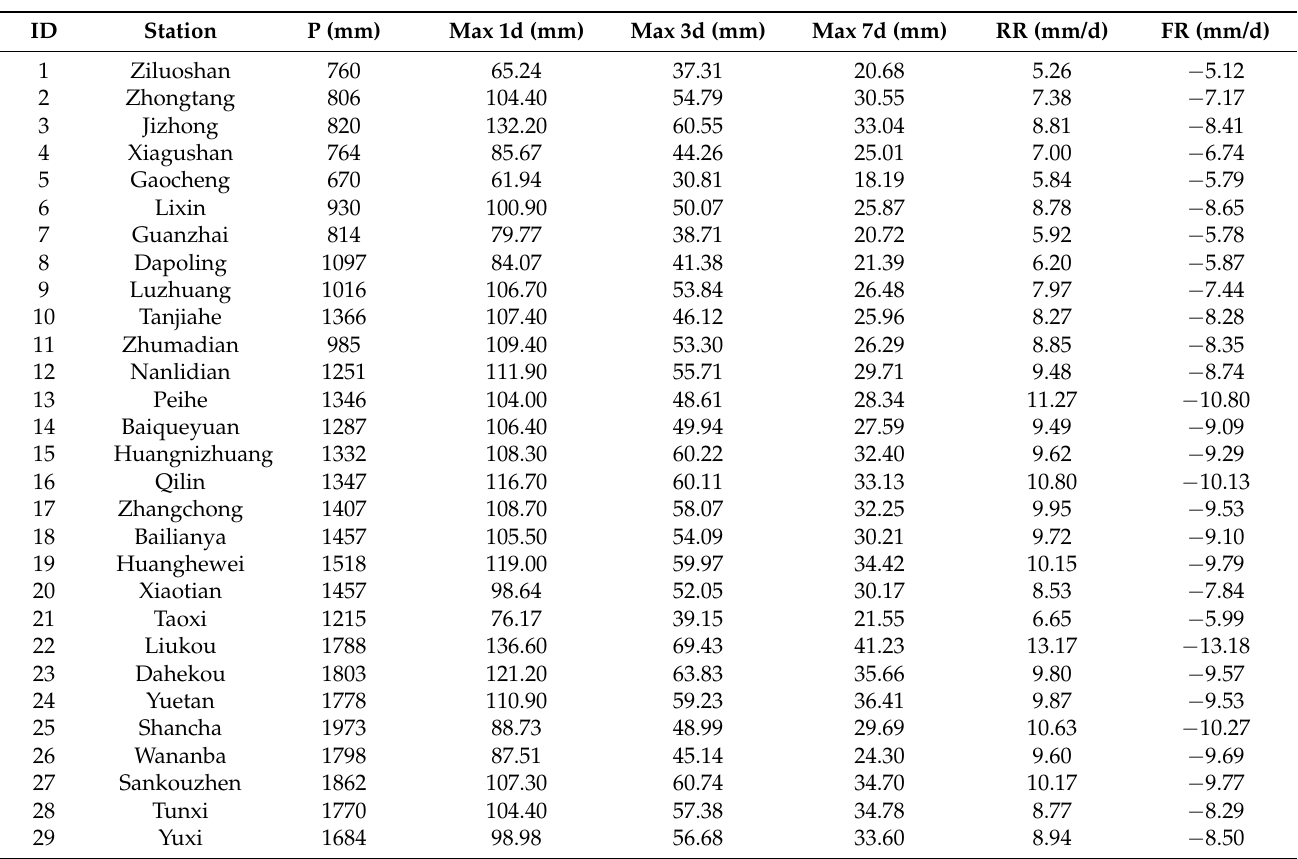
Table A1. 6 rainfall features of 64